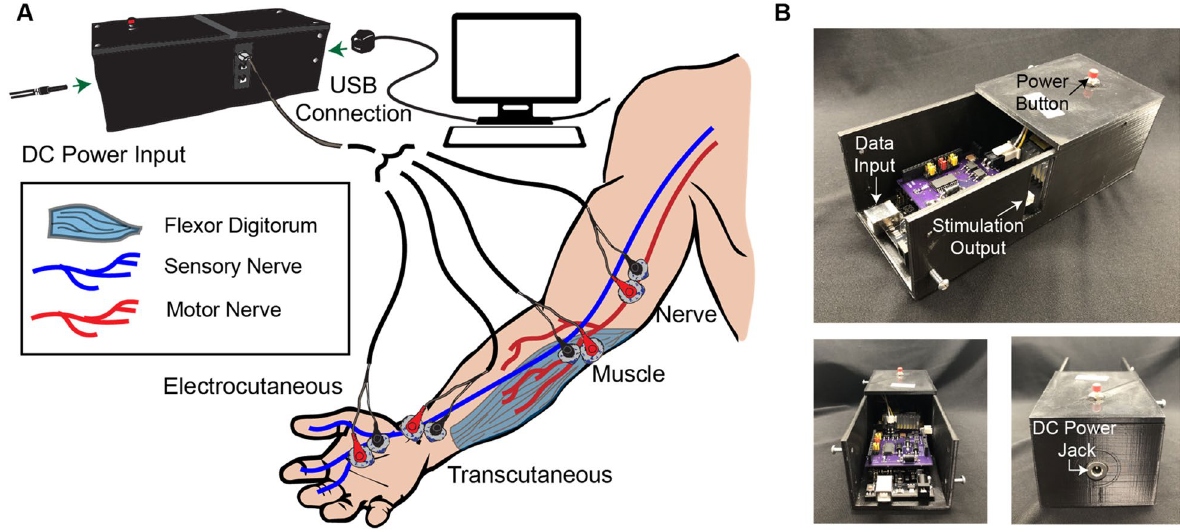
Figure 1. Overview of neural stimulator. ( A ) The stimulator is powered with a 12-V DC barrel connector or battery and communicates with external software using a USB-B connection. The stimulator can be used to noninvasively activate sensory afferent fibers via electrocutaneous applied directly to the sensation site and transcutaneous stimulation applied to the nerve before it innervates the sensory organ. The stimulator also noninvasively activates motor efferent fibers via direct application to the muscle or indirectly to the nerve. ( B ) The stimulator consists of a microcontroller, the stimulation driver, and a DC-DC boost converter encased in a 3D-printed housing. The power to the DC-DC boost converter is connected to a push button that acts as an emergency stop. The stimulator circuitry is designed to stack with the Arduino Uno form factor such that it can be combined with other educational tools built around the Uno form